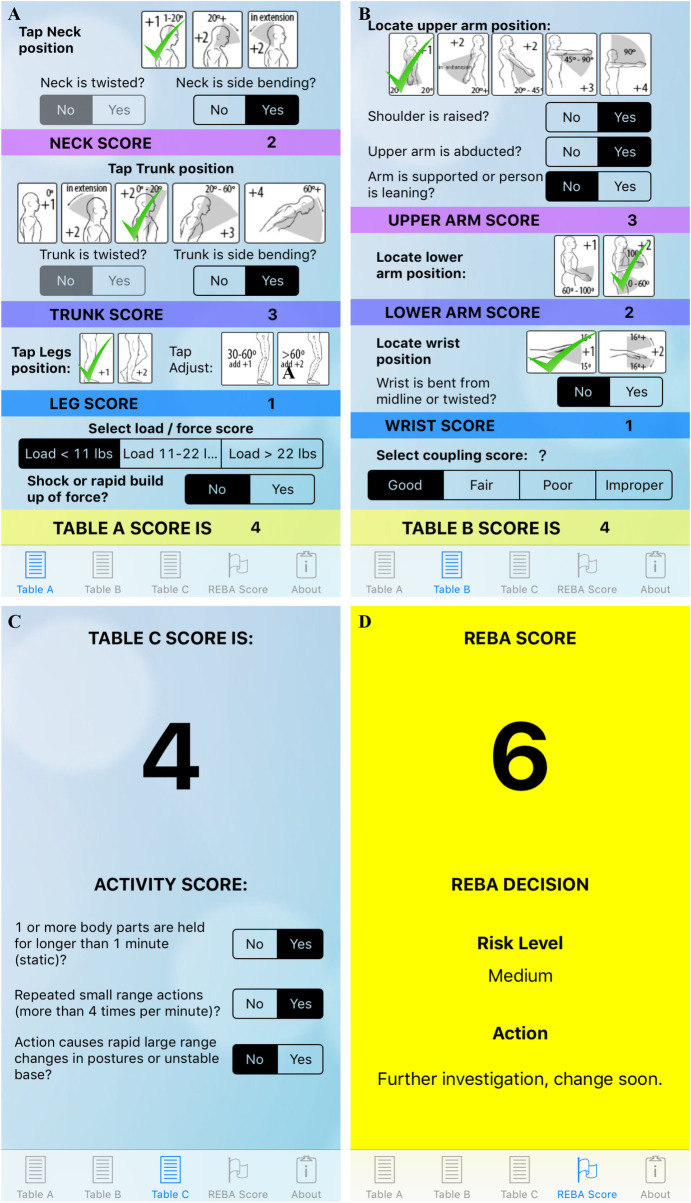
REBA app for intraoperative observation of ergonomic risk assessment severity.(A and B) REBA score for limbs as well as for the head and neck evaluation. (C) Activity score. (D) The REBA final risk level assessment score and recommendation, provided at the end of the assessment where the color represents severity risk as follows: green = low risk (3 or less), yellow = medium risk (4–7), orange = high risk (8–10), red = very‐high risk (11 and above).